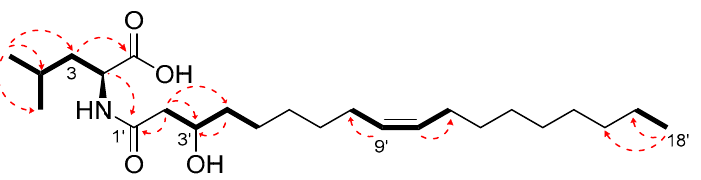
Figure 8. Key COSY (bold lines) and HMBC (red dashed arrows) correlations of Compound 1.